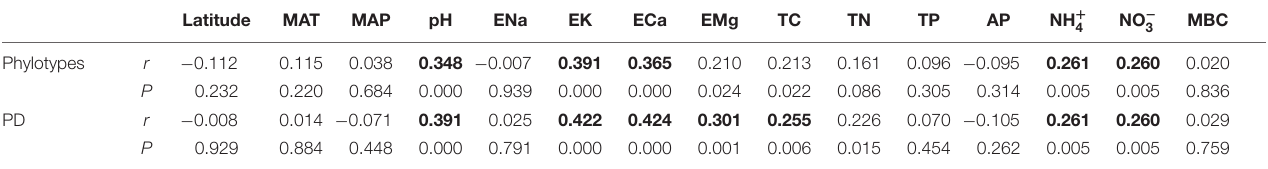
TABLE 3 | The pairwise correlation analysis between soil bacterial diversity indices (phylotypes and phylogenetic diversity, PD for short) and soil location, physical and chemical properties. Latitude MAT MAP pH ENa EK ECa EMg TC TN TP AP NH + 4 NO − 3 MBC Phylotypes r − 0.112 0.115